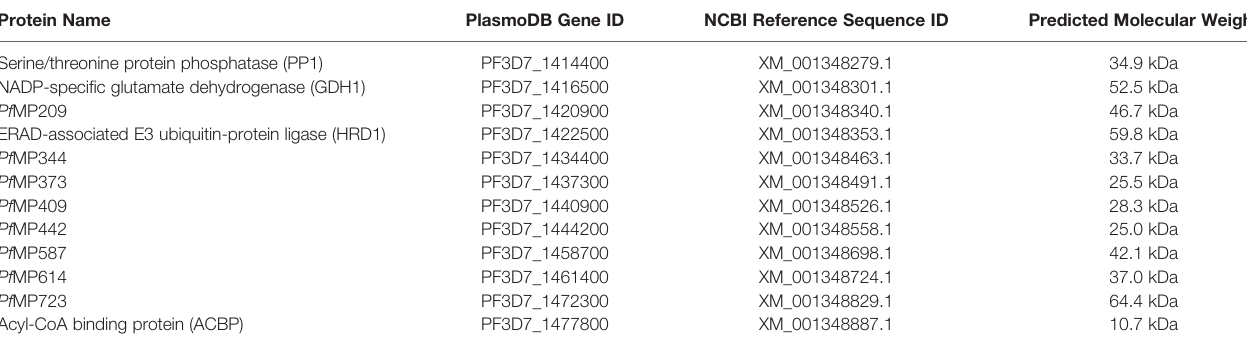
TABLE 1 | Successfully expressed proteins encoded by the brown module genes in chromosome 14 of Plasmodium falciparum 3D7